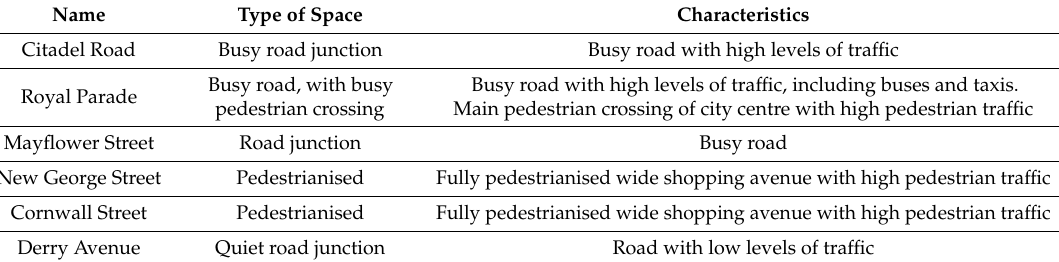
Figure 7. Participant’s walking route—main crossings or junctions along the route. Table 2. Names and characteristics of road junctions along the walking route.